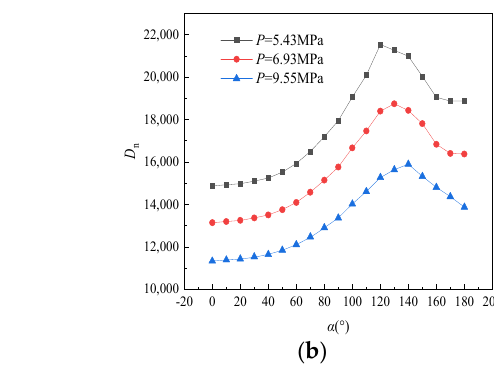
Figure 11. The changes in h with L / D and in Dn with α under different pressure conditions: ( a ) L/D , ( b ) α (°).